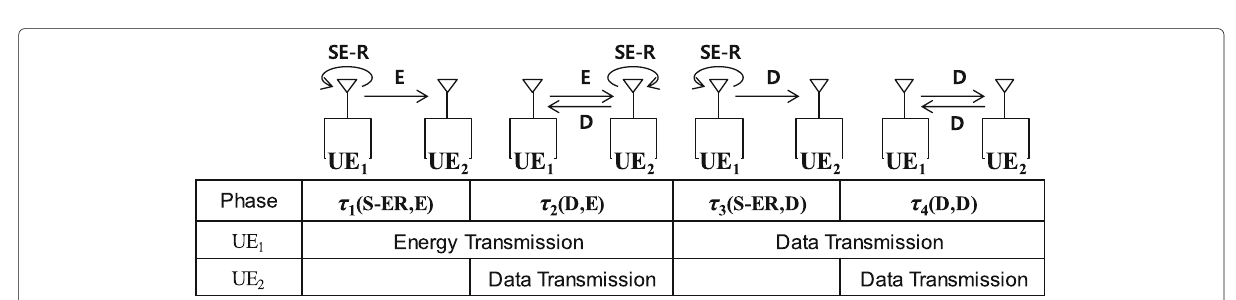
Fig. 1 The system model of the proposed